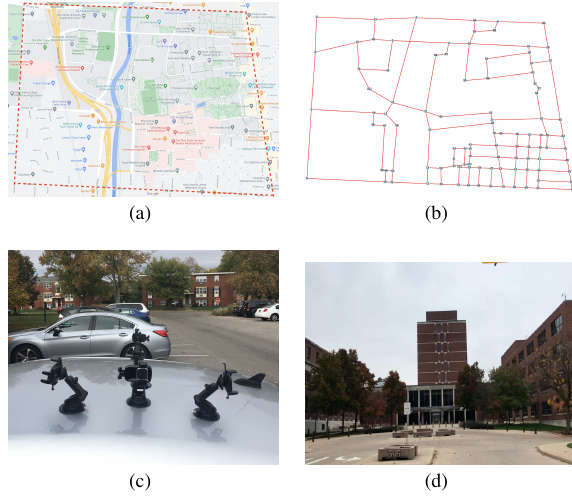
Figure 1. CampusNav covers a range of 2.5km x 1.7km, we illustrate the road network as an undirected graph. The image data is collected by iPhone placed on a moving car.